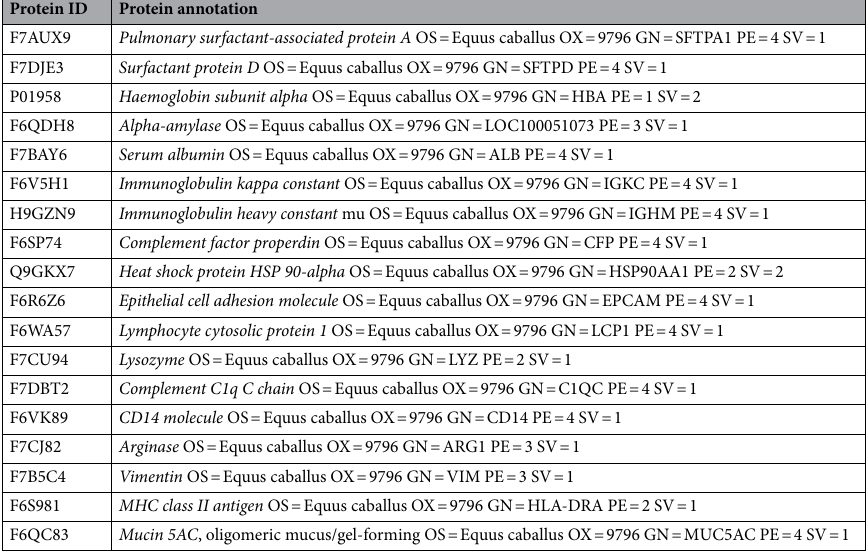
Table 1. List of proteins related to immune response and lung biology derived from tracheal wash